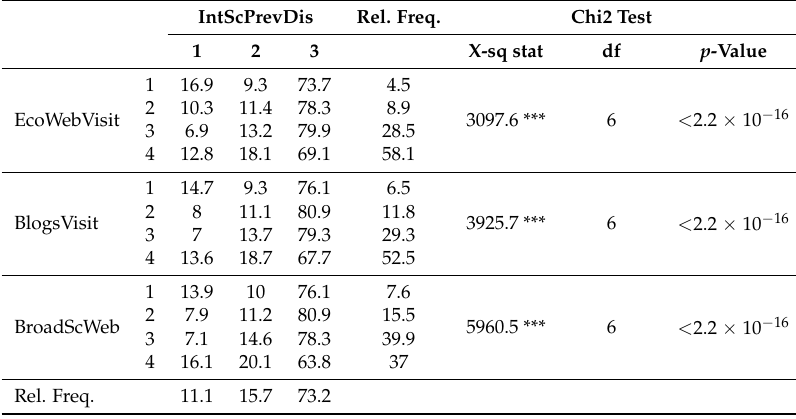
Table A3. Chi-square test results with conditional and relative frequency distributions in % for “IntScPrevDis”.